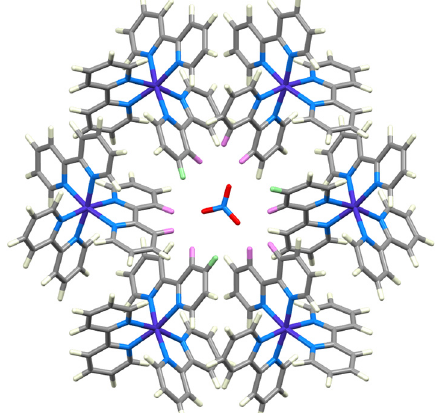
Figure 6. Packing motif in [Co(bpy) 3 ][NO 3 ] 2 . H 2 O . MeCN (CSD refcode XARPEN [48]); the second symmetry-related [NO 3 ] – is omitted for clarity. The H3 and H3 ′ atoms in the bpy ligand which show short contacts to the [NO 3 ] – ion are shown in pink and H4 atoms in green.